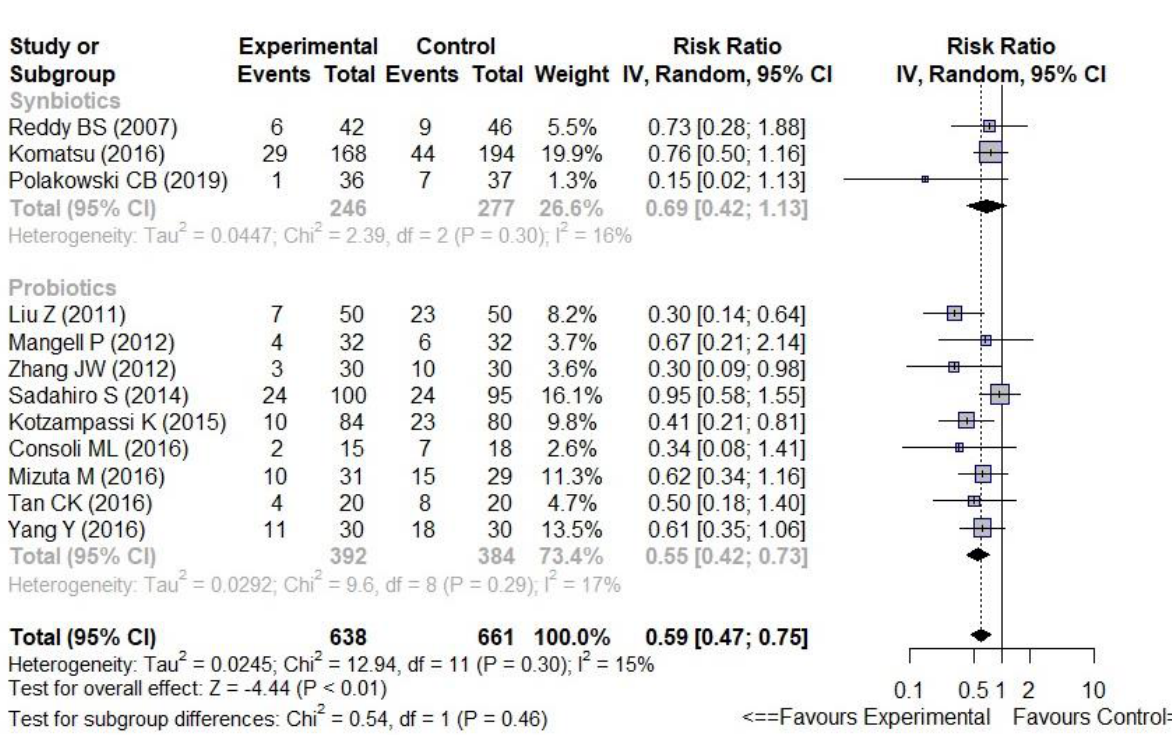
Figure 4. Forest plot of probiotics [26–28,31–33,35–37] versus synbiotics [24,34,40]. Outcome = overall infectious complications.